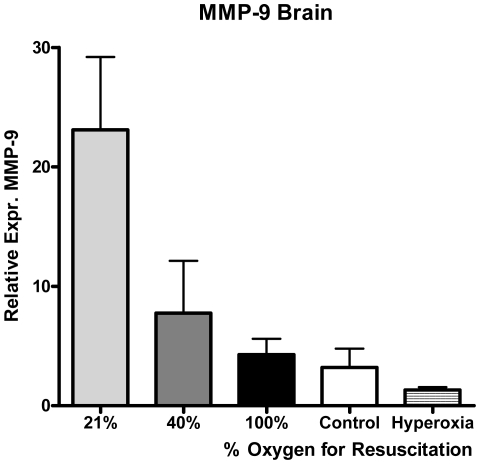
MMP-9 mRNA expression in the cortex.Relative mRNA MMP-9 expression was significantly increased in the 21% oxygen group vs. all the others: 21% (n = 10) 23.1 (19.3), 40% (n = 12) 7.8 (15.1), 100% (n = 10) 4.3 (4.2), hyperoxia (n = 11)1.8 (1.6), control (n = 6) 3.9 (4) with p = 0.029, 0.007, 0.001 and 0.017, respectively.